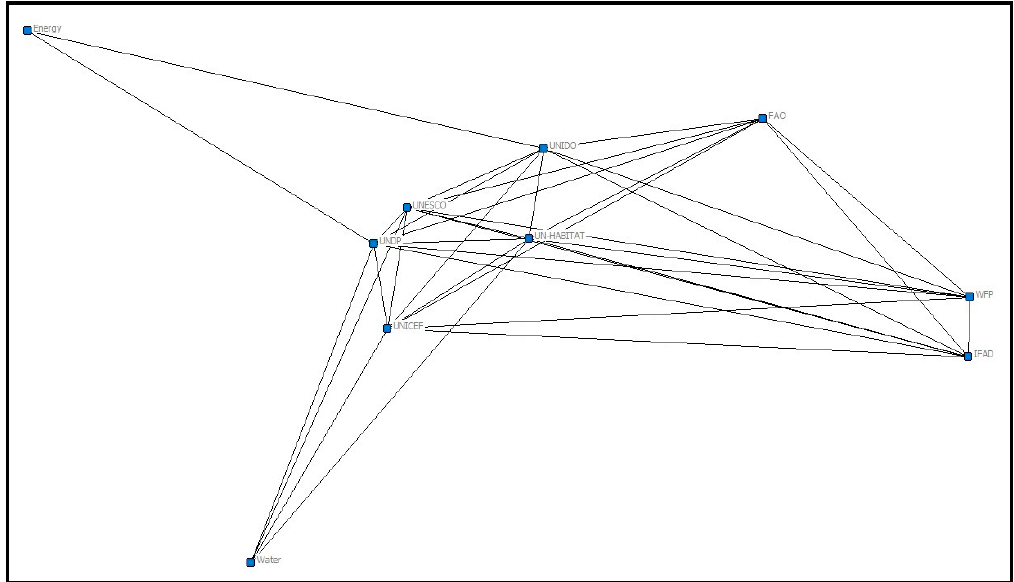
Figure 2 . Organizations—Food–Energy–Water (FEW) and partnership network. Figure 2. Organizations—Food–Energy–Water (FEW) and partnership network.